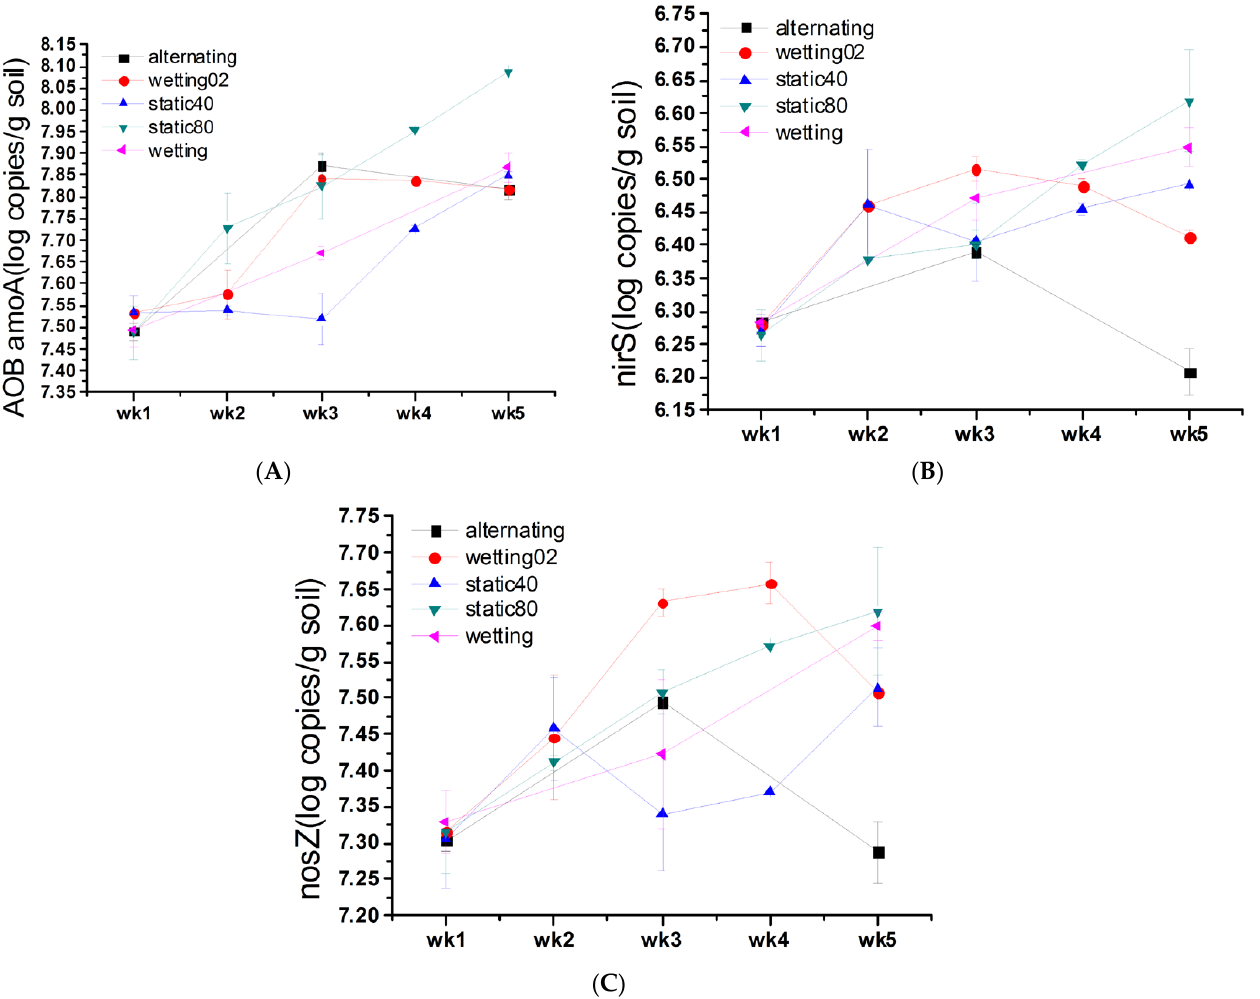
Figure 8. qPCR shows the temporal alterations of AOB amoA abundance ( A ), nirS abundance ( B ), and nosZ abundance ( C ) under four types of moisture regimes. Alternating: a20 (sampling at the end of the first week) → a80 (sampling at the end of the third week) → a40 (sampling at the end of the fifth week); wetting: a20 → w40 (sampling at the end of the third week) → w80 (sampling at the end of the fifth week); wetting02: a20 → w2_40 (sampling at the end of the second week) → w2_60 (sam- pling at the end of the third week) → w2_80 (sampling at the end of the fourth week) → w2_100 (sam- pling at the end of the fifth week); static(constant)40: a20 → s40 (sampling at the end of each week); static(constant)80: a20 → s80 (sampling at the end of each week).